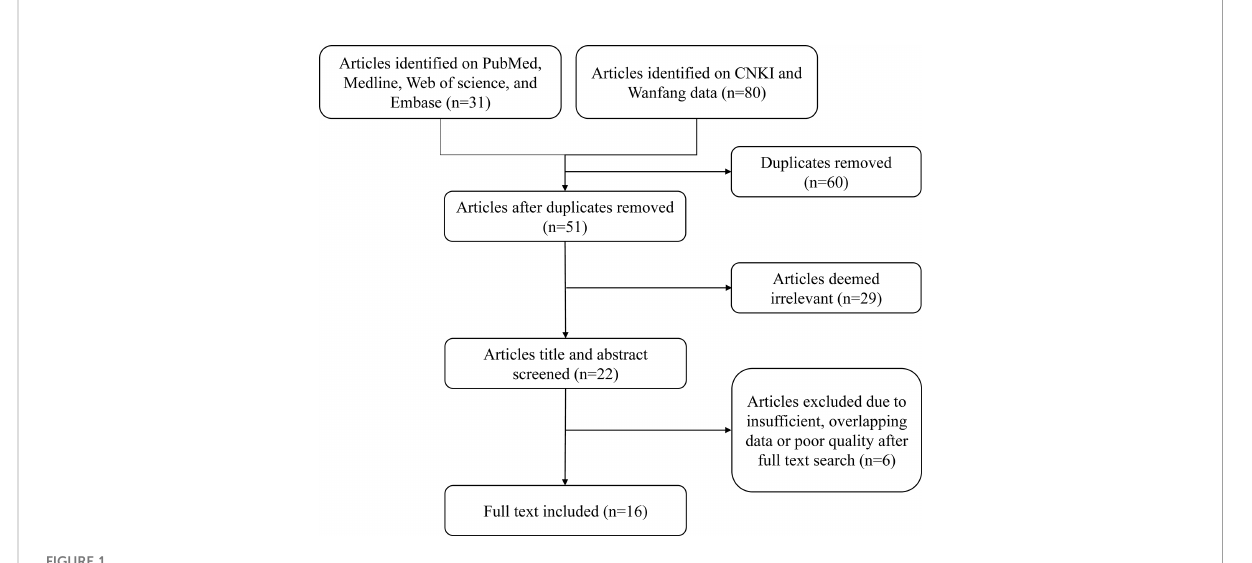
FIGURE 1 Flow diagram of the article selection process.